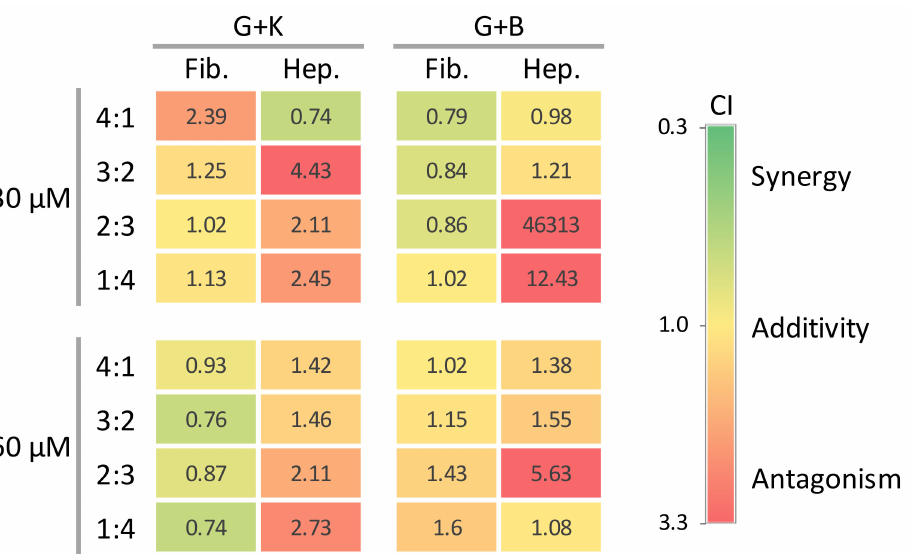
Figure 10. Interactions between flavonoids in two-component mixtures regarding the effect on GAG synthesis in fibroblasts and hepatocytes. The heat map shows colour-coded combination index values calculated from experimental data obtained for genistein mixed with either biochanin A or kaempferol at non-constant ratios (4:1, 3:2, 2:3, and 1:4) and total flavonoid concentrations of 30 and 60 µ M. Fib.—fibroblasts, Hep.—hepatocytes, B—biochanin A, G—genistein, K—kaempferol, CI—combination